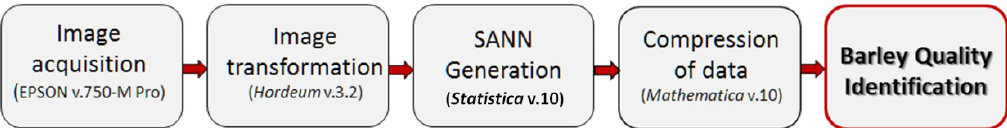
Figure 7. Schematic procedure of neural classification.